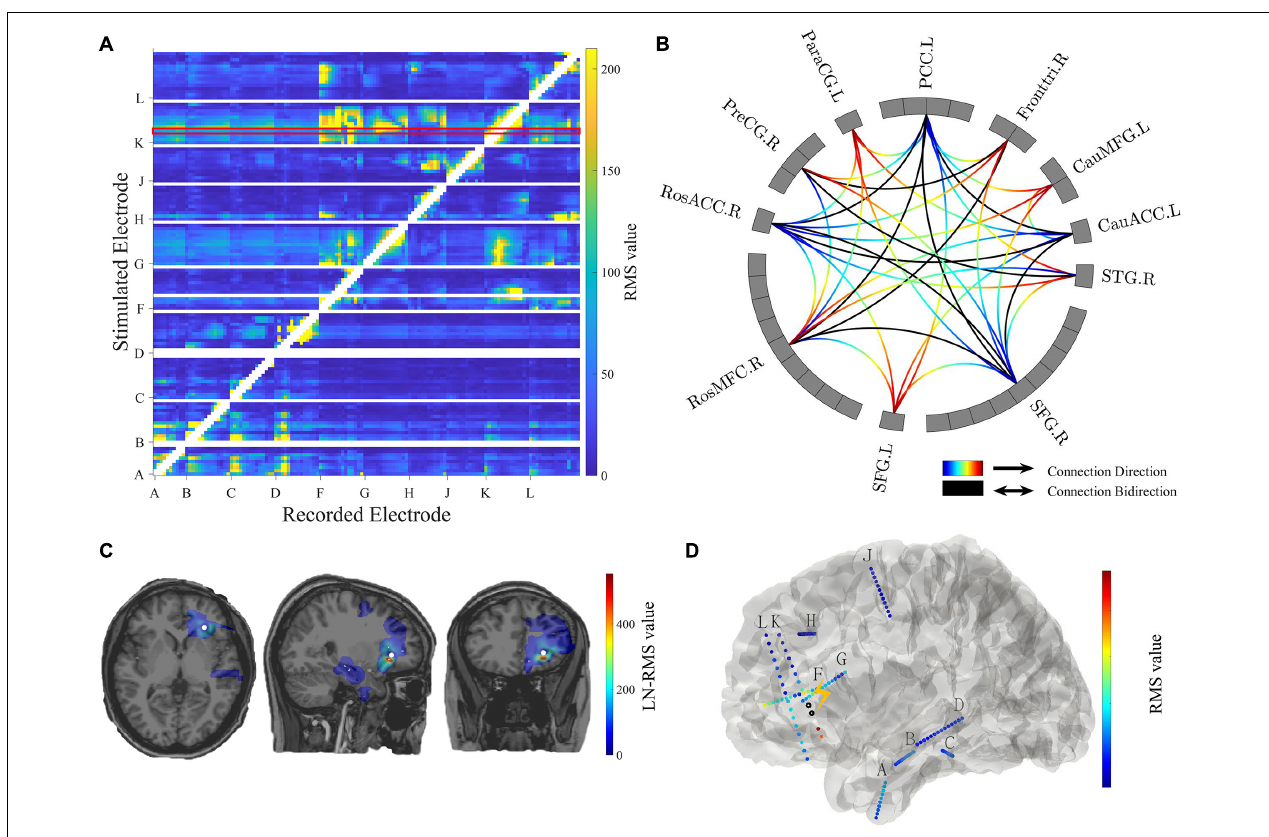
FIGURE 4 | Connectivity visualization. (A) Connectivity matrix. The stimulated electrodes are shown in the y-axis and the recorded electrodes are shown in the x-axis. The color-coded numbers represent RMS values here, which depends on the selection of response indicators in the main GUI toolbox. The unstimulated pairs and recorded electrodes with a short distance (radius < 5 mm) to the stimulation pair are illustrated in white. The exampled stimulation result marked in the red box is shown in panels (C,D) . (B) Circle map visualization. The number of rectangular boxes in each compartment represents the number of contacts in each region labeled aside (L = left, R = right, RosACC = rostral anterior cingulate cortex, RosMFG = rostral middle frontal gyrus, SFG = superior frontal gyrus, STG = superior temporal cortex, CauACC = cauda lanterior cingulate cortex, CauMFG = caudal middle frontal gyrus, Fronttri = parstriangularis of the inferior cortex, PCC = posterior cingulate cortex, ParaCG = paracentral gyrus, PreCG = precentral gyrus). The curves represent significant connectivities. The gradient color curves represent directional connectivity (from blue to red) and the black color curves represent bi-directional connectivity. (C) Brain response mapping is shown in individual volume space in a format of linear interpolation surrounding the implanted electrodes. The white dot indicates stimulation position. (D) Surface view. All contacts and electrode labels are shown in the 3D surface view and the color represents the RMS value. The black circle dots represent stimulation